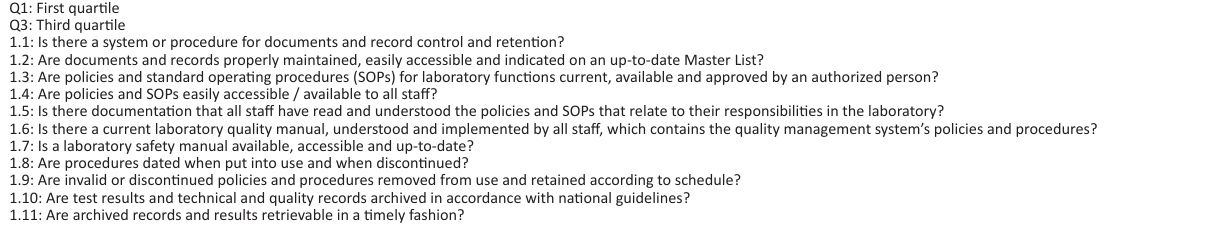
FIGURE 1: Example of e-Tool data output for baseline (row 1) and exit audit (other rows) for Section 1 (Documents and Records) compiled from 12 laboratories in Vietnam,